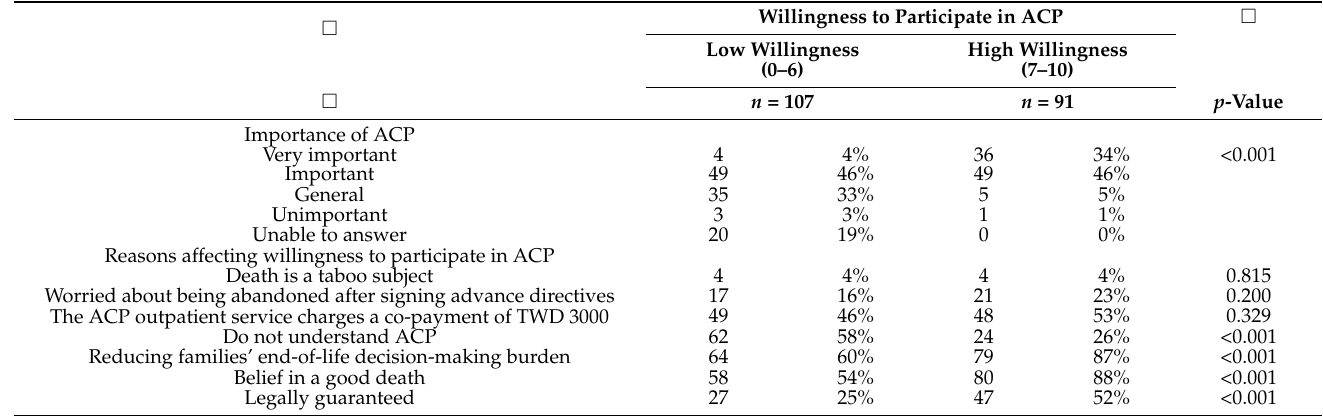
Table 2. Awareness of ACP a and reasons affecting willingness to participate in